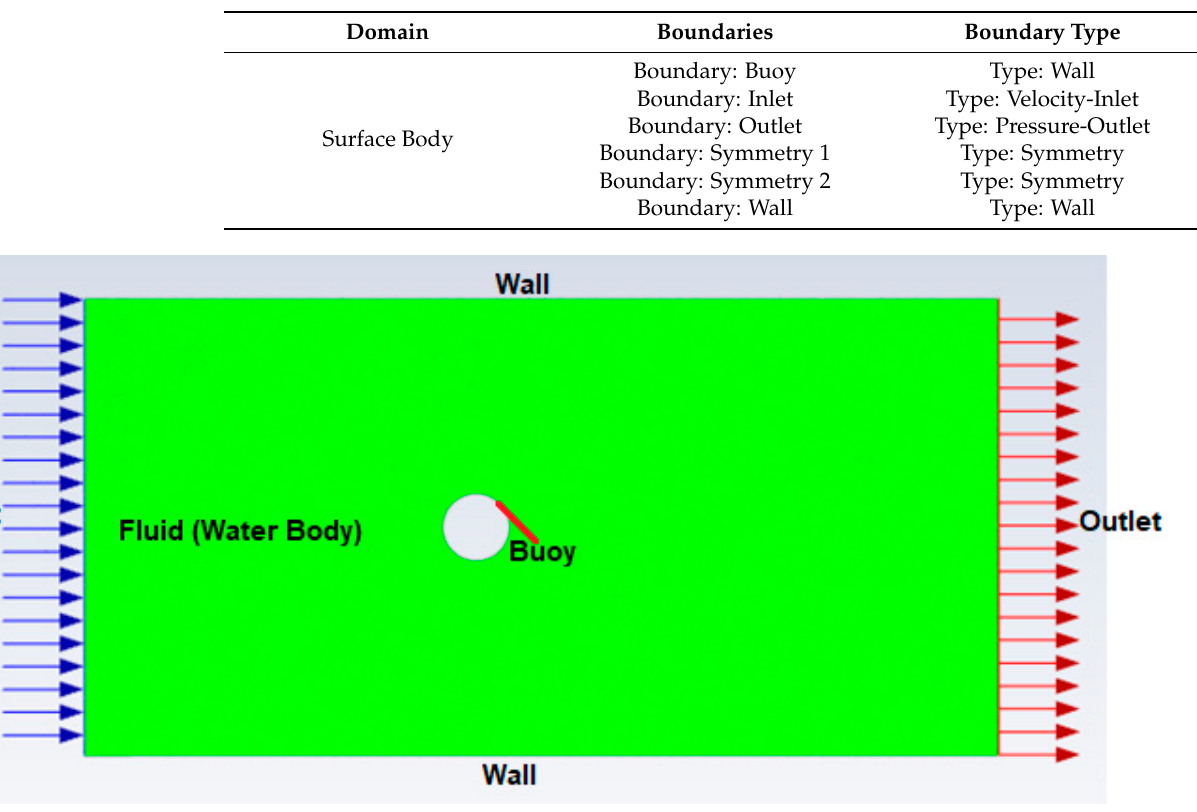
Figure 8. The setup of the buoy in ANSYS CFD showing boundary conditions. Table 6. Properties of fluid (sea water) used in the FSI model in ANSYS Fluent. Parameters